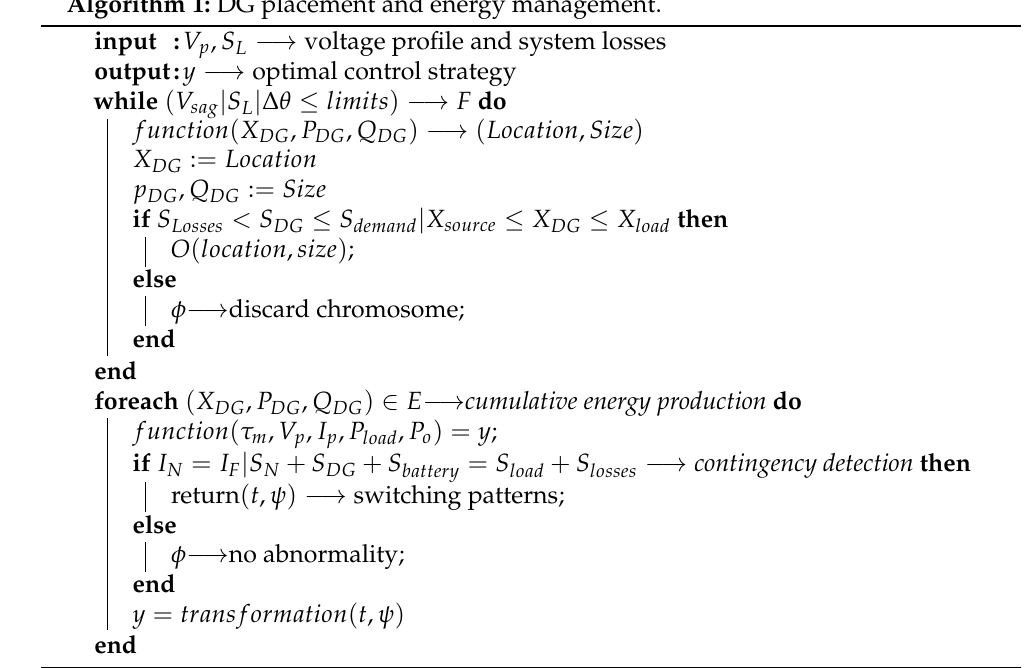
Algorithm 1: DG placement and energy